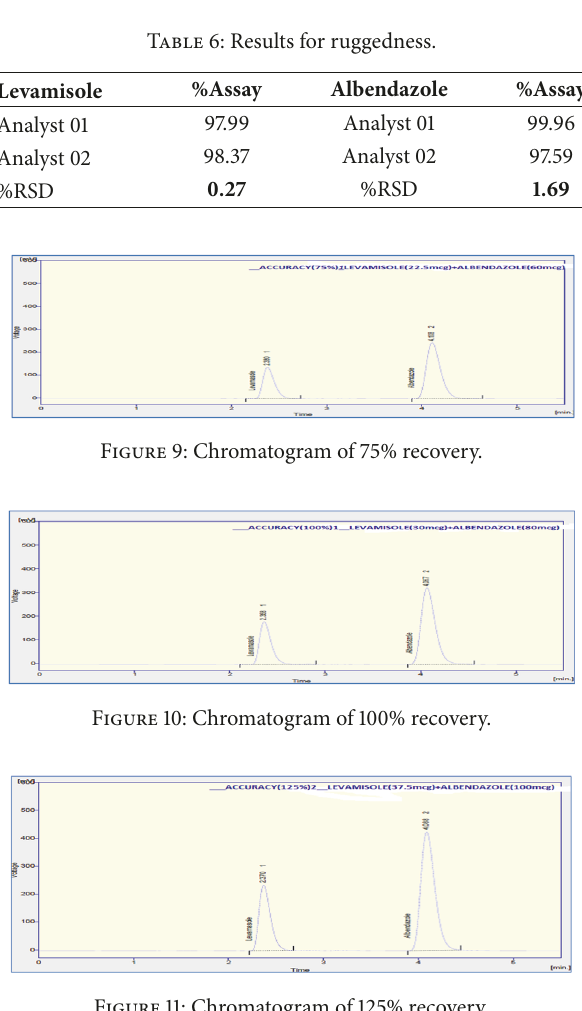
Figure 11: Chromatogram of 125% recovery.